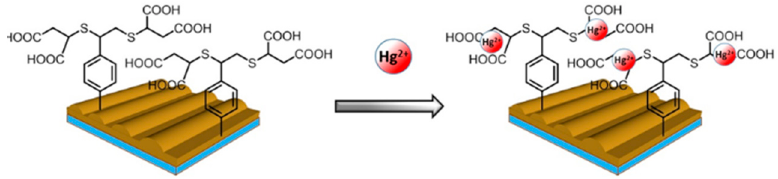
Figure 4. Representation of Hg 2 + ion capture by gold grating grafted with mercaptosuccinic acid.